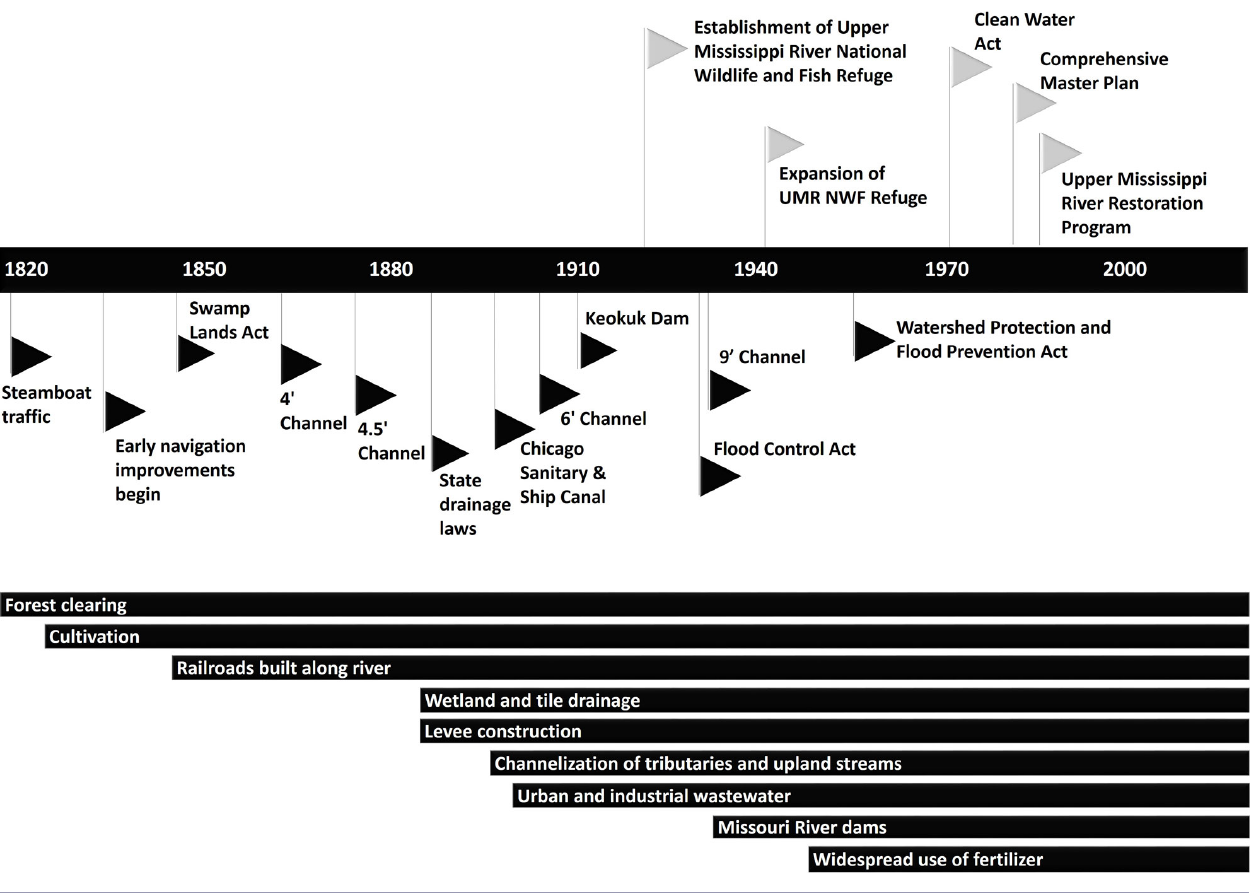
Fig. 2 . A time line of historic changes to the Upper Mississippi River and its basin that have influenced the physical and ecological characteristics of the